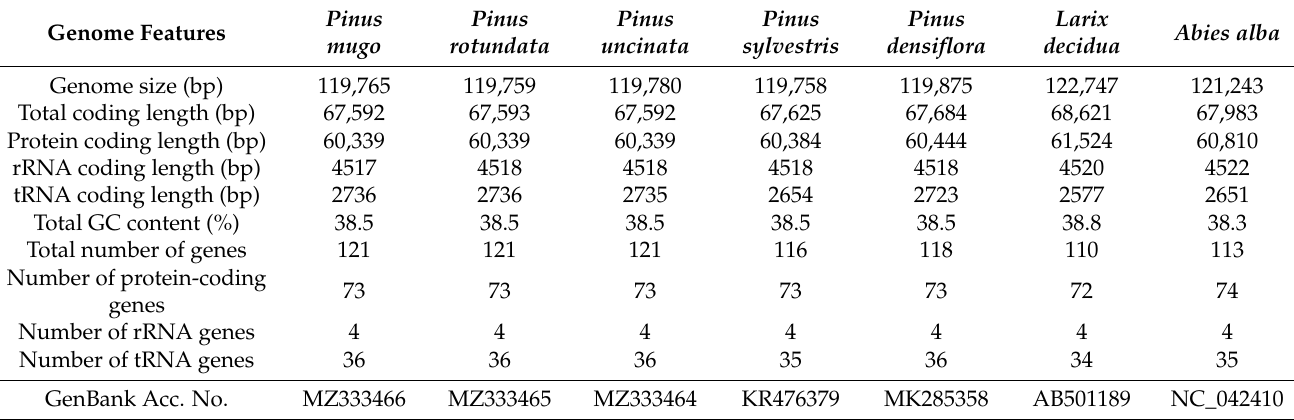
Table 1. Basic features of chloroplast genomes among the seven taxa of